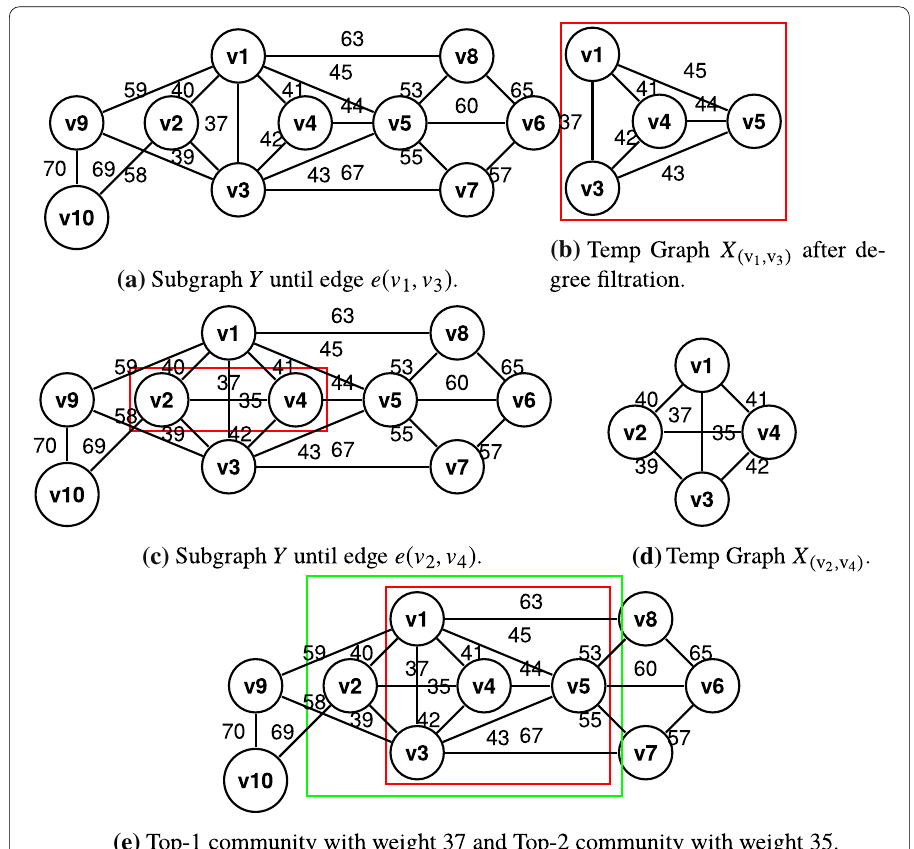
Fig. 5 Running example for